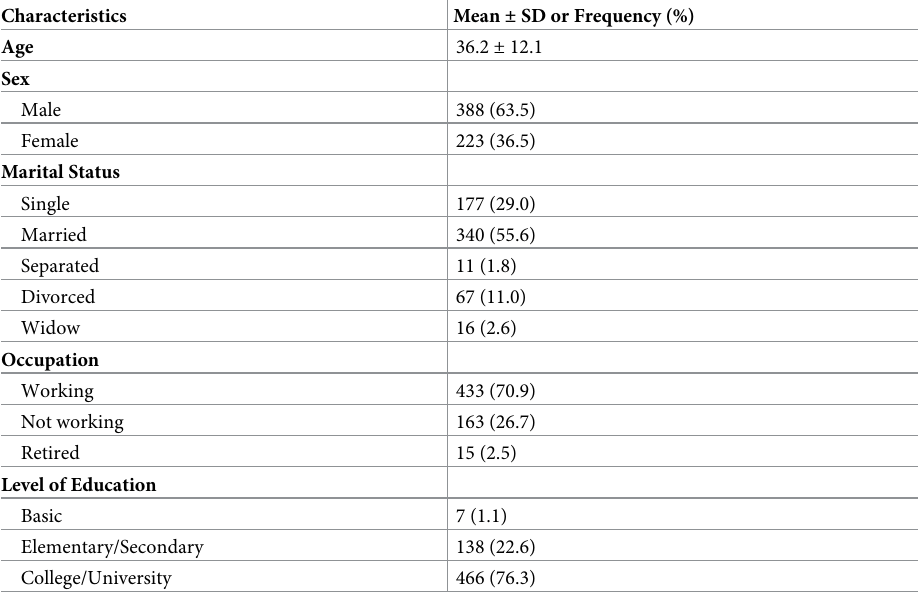
Table 1. Socio-demographic characteristics (N =